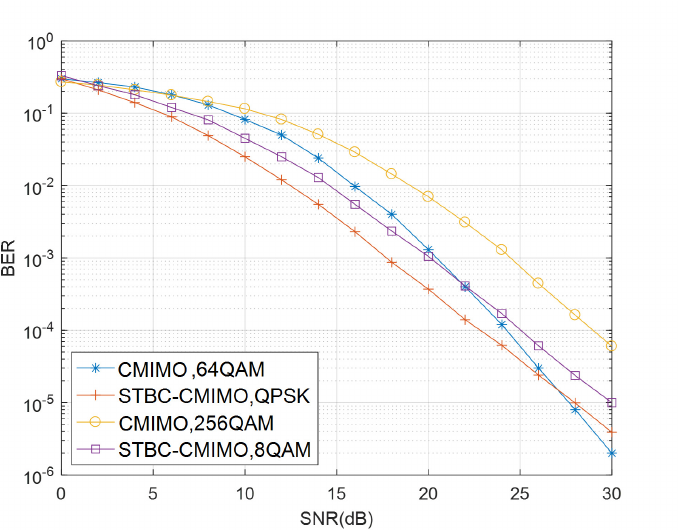
Figure 4. Performance comparison of STBC-CMIMO and conventional CMIMO at 6 and 8 bits/s/Hz spectral